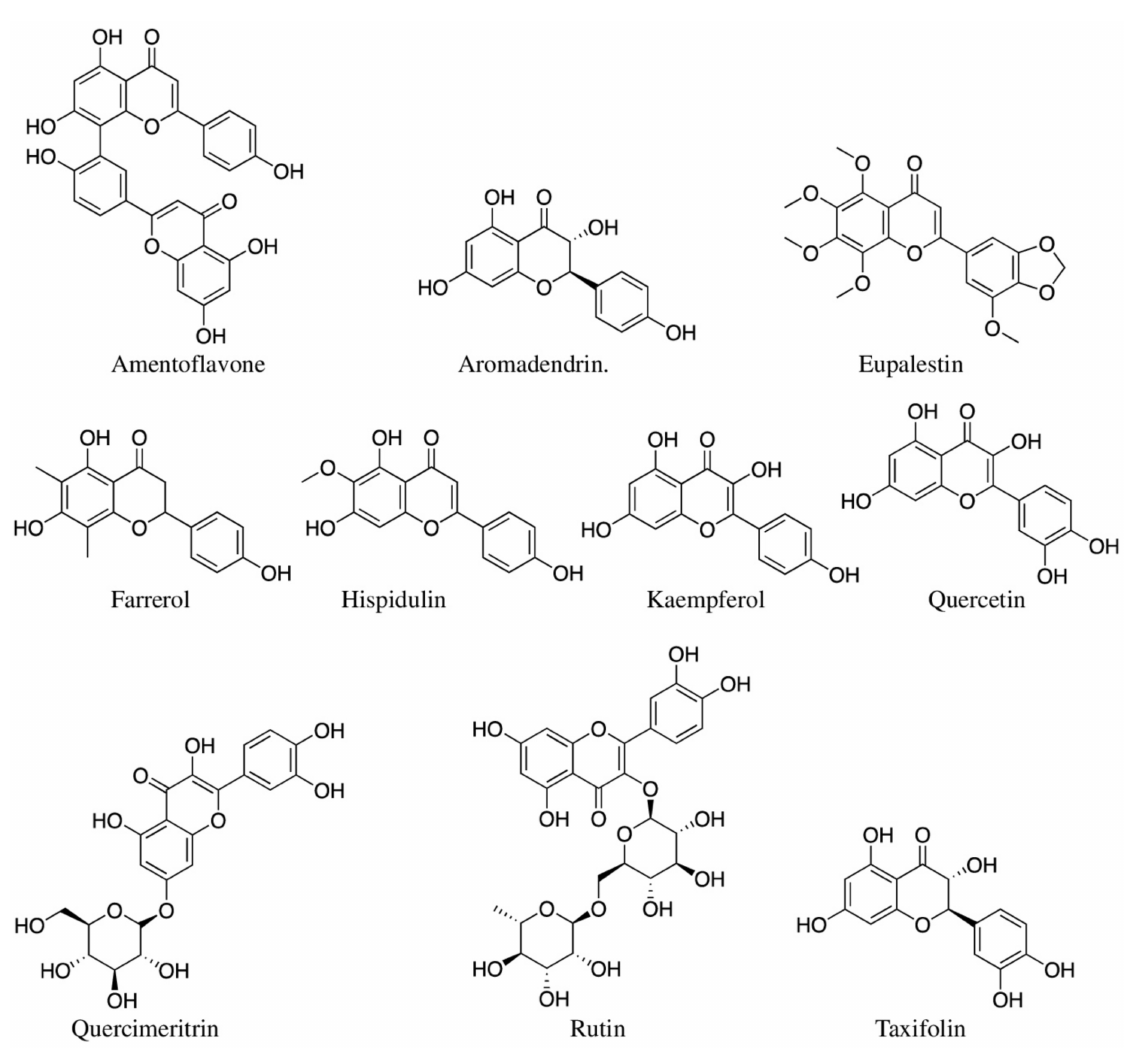
Figure 6. Chemical structures of anti-inflammatory